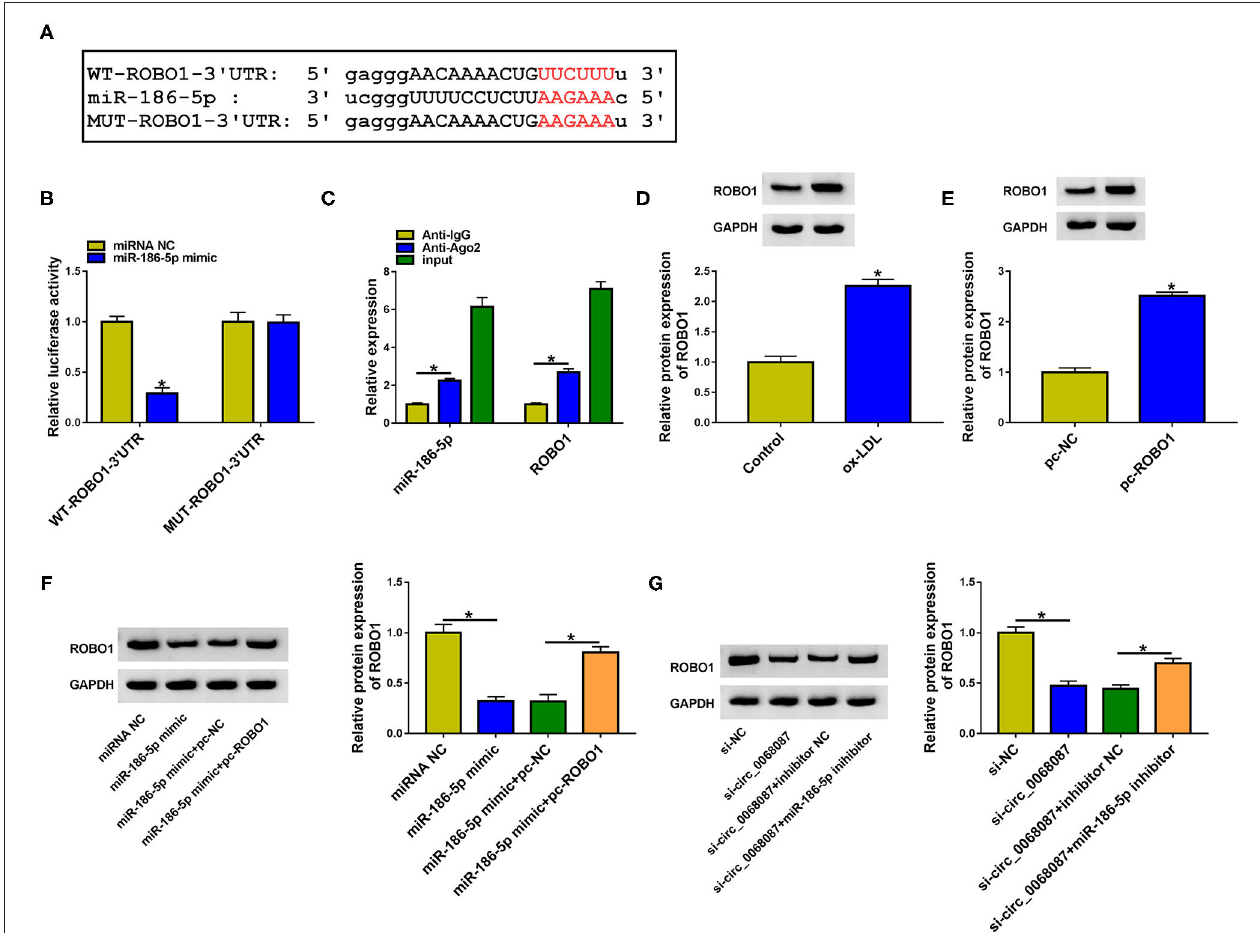
FIGURE 5 | MiR-186-5p interacts with the 3’UTR of ROBO1 in HUVECs. (A) The putative binding sequence between miR-186-5p and ROBO1 predicted by the StarBase database is shown. (B) Dual-luciferase reporter assay was performed to confirm if ROBO1 was a target of miR-186-5p in HUVECs. This experiment was performed three times with three technical repetitions each time. An unpaired Student t -test was used to evaluate the differences. (C) RIP assay was applied to confirm the target relation between ROBO1 and miR-186-5p. This experiment was performed three times with three technical repetitions each time. An unpaired Student t -test was used to evaluate the differences. (D) The protein expression of ROBO1 was measured in HUVECs treated with ox-LDL (40 mg/L, 24h) by Western blot assay. This experiment was performed three times. An unpaired Student t -test was used to evaluate the differences. (E) The overexpression efficiency of ROBO1 plasmid (pc-ROBO1) was analyzed by Western blot assay. This experiment was performed three times. An unpaired Student t -test was used to evaluate the differences. (F) HUVECs were transfected with miR-186-5p mimic alone or together with pc-ROBO1, and the protein level of ROBO1 was measured by Western blot assay. This experiment was performed three times. One-way ANOVA followed by Tukey’s post hoc test was used to assess the differences. (G) The protein expression of ROBO1 was determined in HUVECs transfected with si-circ_0068087 alone or together with miR-186-5p inhibitor by Western blot assay. This experiment was performed three times. One-way ANOVA followed by Tukey’s post hoc test was used to assess the differences. * P <